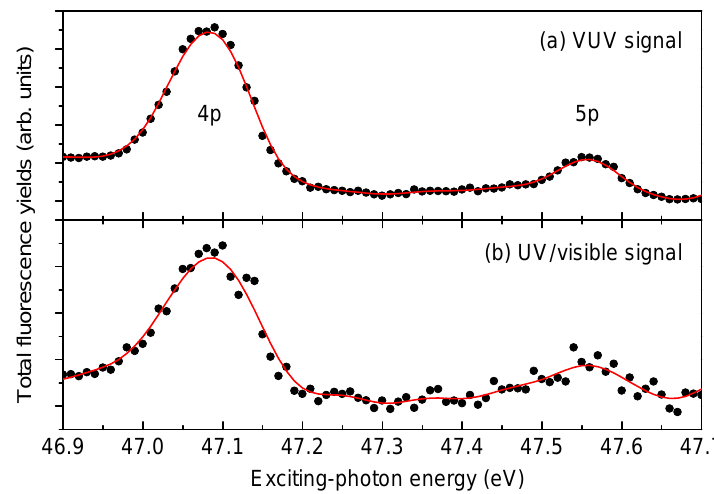
Figure 8. Partial photon yield excitation function in ( a ) the VUV (<130 nm) and ( b ) the UV/visible (300–630 nm) spectral ranges after 2s → 4p and 2s → 5p resonant excitation of neon clusters. The maxima appear due to the non-local autoionization process termed resonant interatomic Coulombic decay. Reprinted from Chemical Physics 482, 165–168, Copyright (2017) [44], with permission from Elsevier.